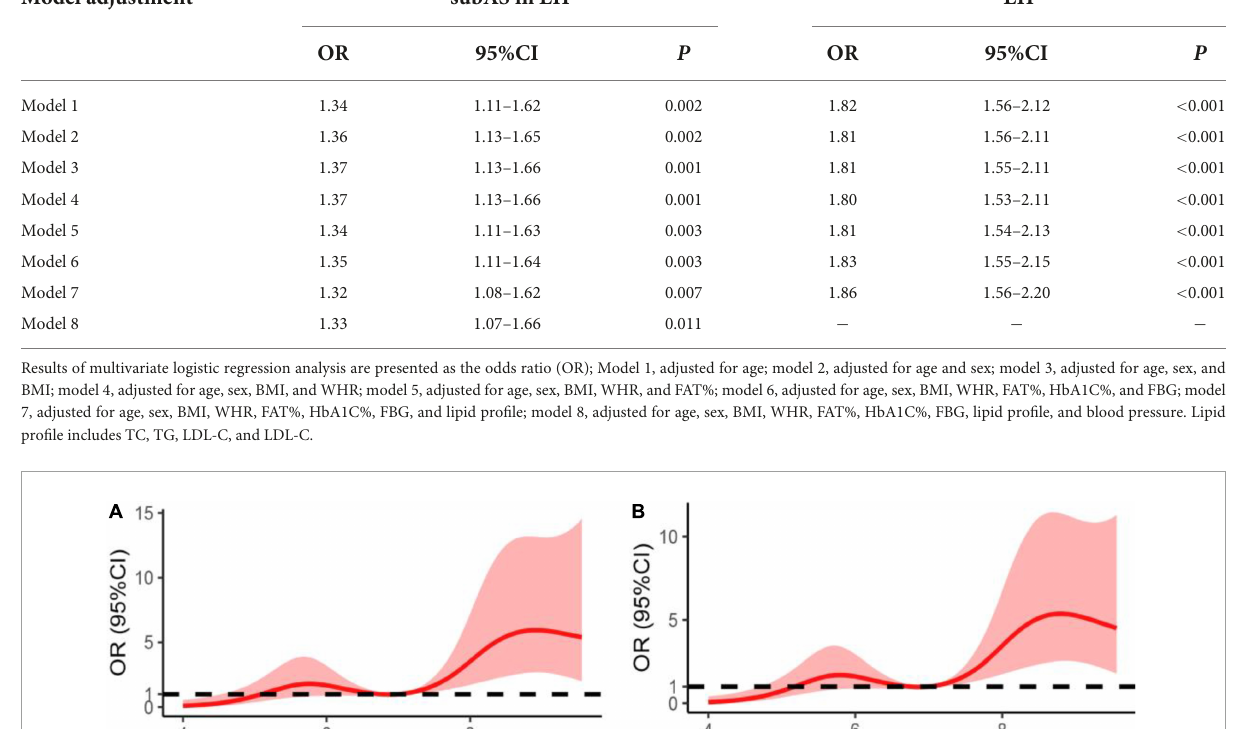
TABLE 3 Odds ratio of circulating sortilin levels with EH and subAS in EH by multivariate logistic regression analysis. Model adjustment